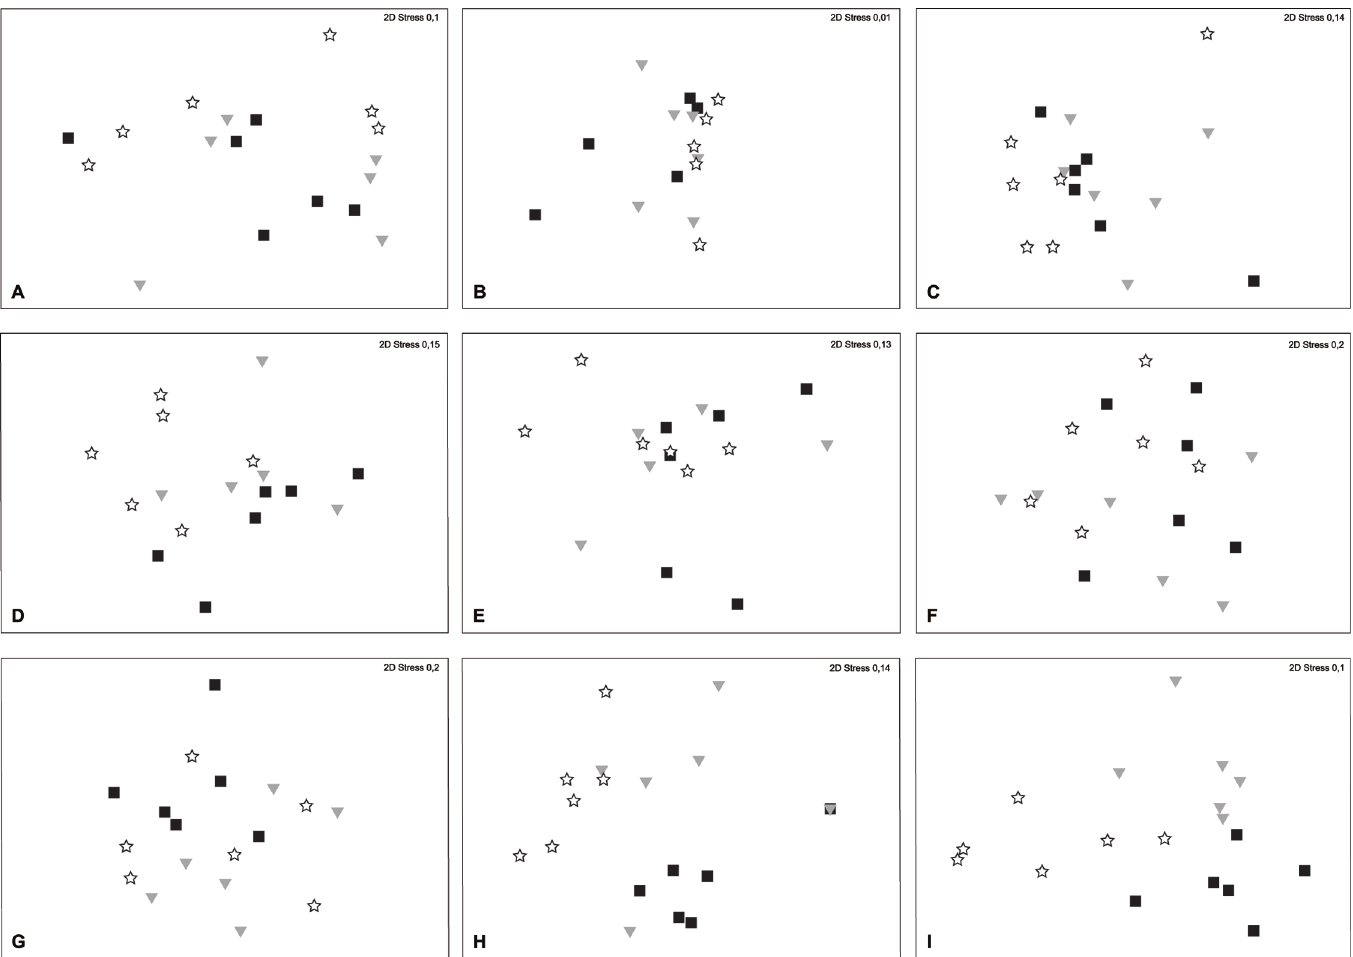
Fig 3. nmMDS of communities at the different size-levels. White stars label samples of the area A, gray triangles samples of the area B and black squares samples of the area C. (A) bacterial communities characterized by T-RFLP with the enzyme AluI, (B) bacterial communities characterized by T-RFLP with the enzyme BsuRI, (C) bacterial communities characterized by LH-PCR, (D) microbial eukaryotes communities characterized by T-RFLP with the enzyme AluI, (E) microbial eukaryotes communities characterized by T-RFLP with the enzyme BsuRI, (F) microbial eukaryotes communities characterized by LH-PCR in the region V1, (G) microbial eukaryotes communities characterized by LH-PCR in the region V4, (H) meiofauna communities, (I) macrofauna communities at the higher taxonomic level.